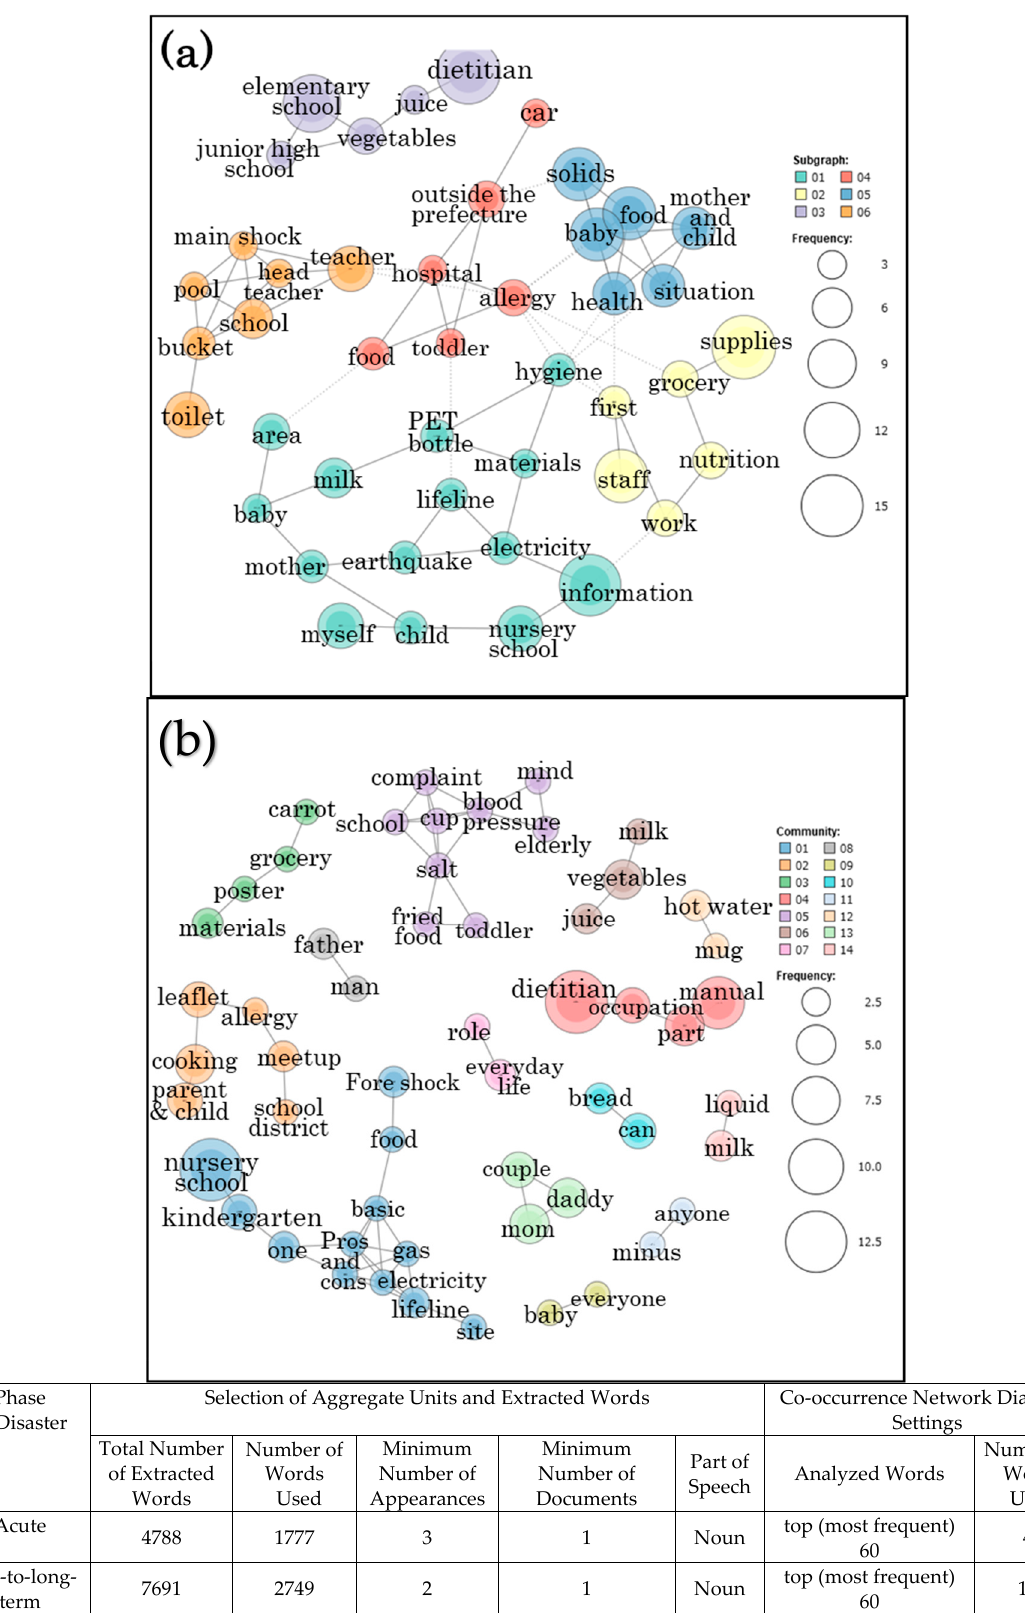
Figure 2. Co-occurrence network diagrams of Group 2 (Surrounding Area) created using quantitative text analysis: Kumamoto earthquake. ( a ) acute phase; ( b ) mid-to-long-term phase.